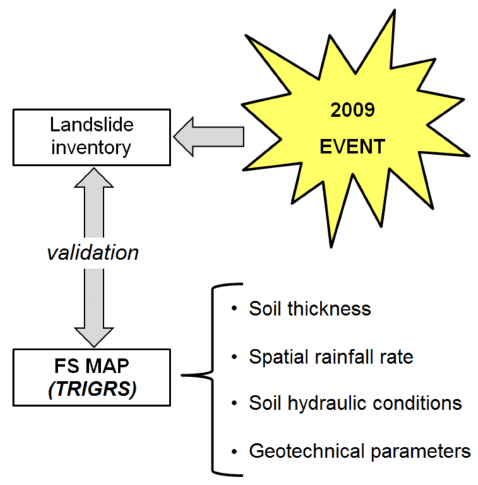
Figure 5. Summary of the back analysis process used for the 2009